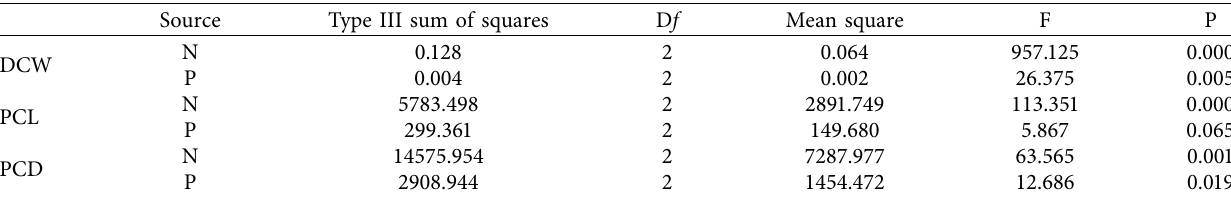
Table 2: The response value of dry cell weight (DCW), phycocyanin content in liquid (PCL), and phycocyanin content in dried Spirulina (PCD) in different culture conditions. N1 N2 N3 R N P1 R P DCW PCD Each content was measured once. N1, N2, and N3 were different concentrations of NH 4 Cl (0.1, 0.2, and 0.3mg/L); P1, P2, and P3 were different con- centrations of K Table 3: Variance analysis of dry cell weight (DCW), phycocyanin content in liquid (PCL), and phycocyanin content in dried Spirulina